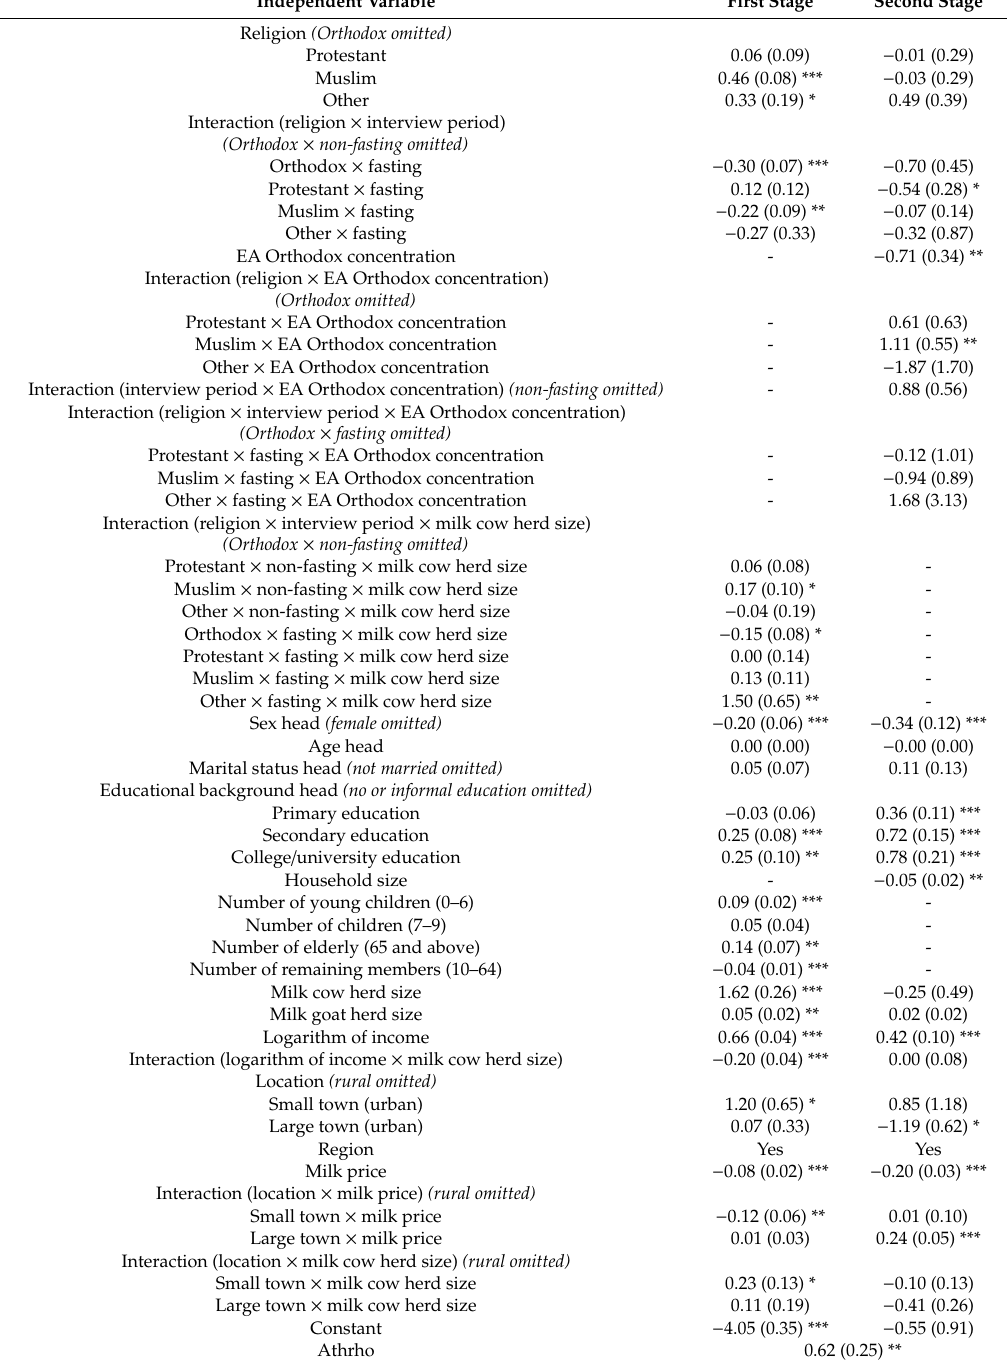
Table 5. Results from the Heckprobit model testing the likelihood to consume purchased